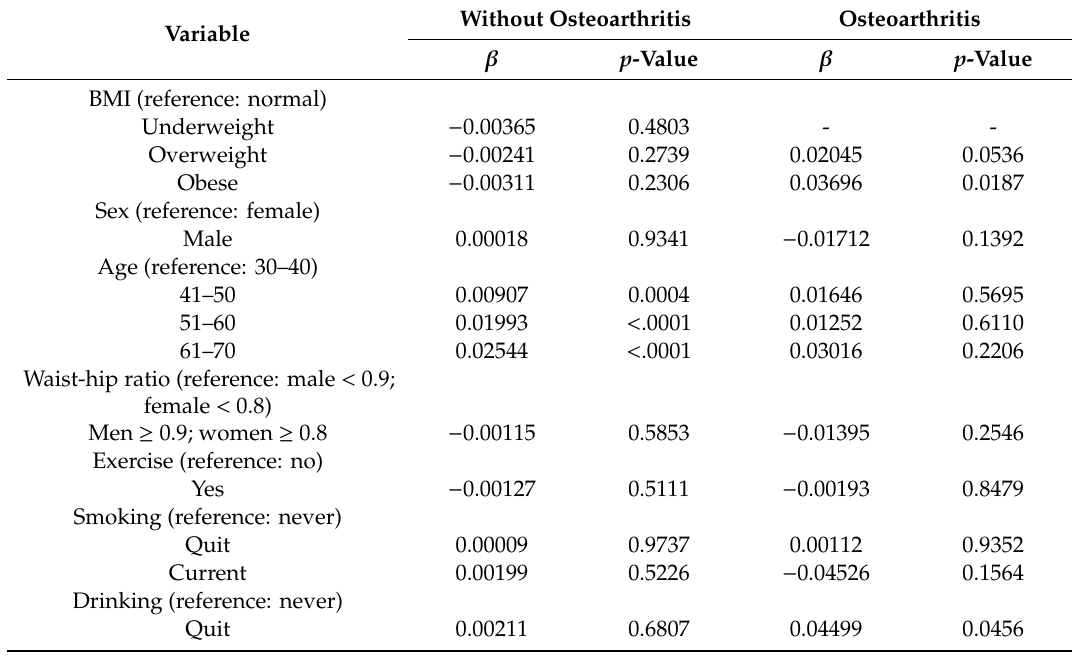
Table 3. Multiple linear regression showing the association between LEP promoter methylation and BMI stratified by osteoarthritis